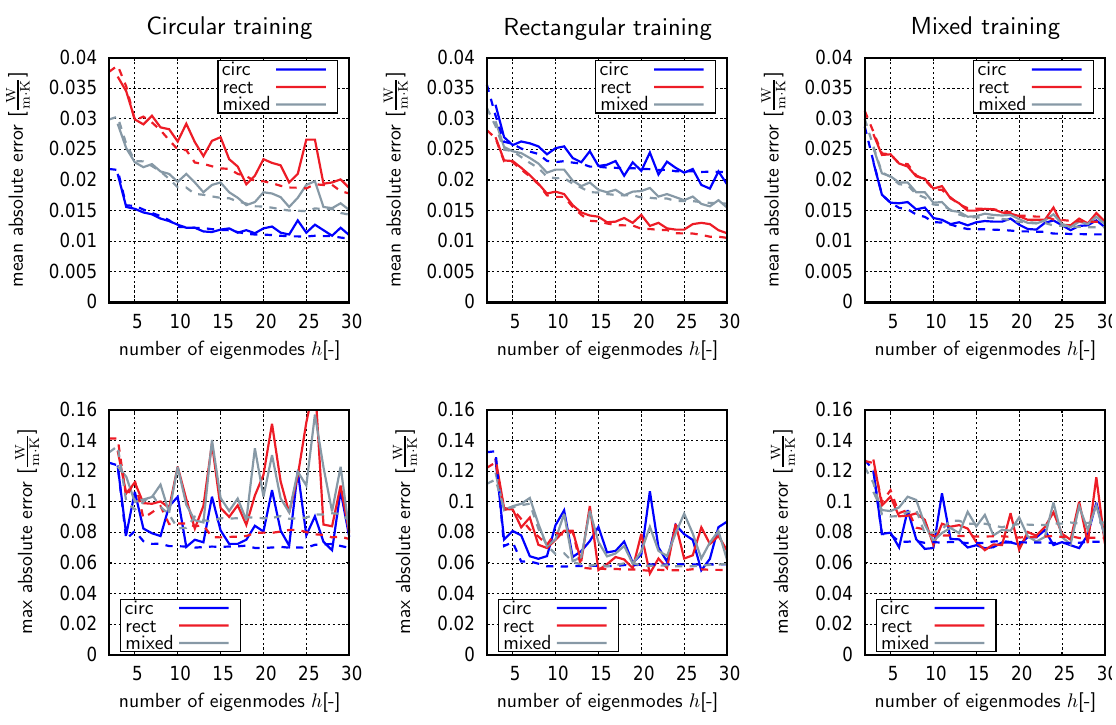
Figure 9. The given error measures over the test sets are shown for the Gaussian Process Model (GPM) (dashed lines) and the Artificial Neural Networks (ANN) (full lines) which achieved the lowest MSE (cost) on the validation set for each number of reduced coefficients and training